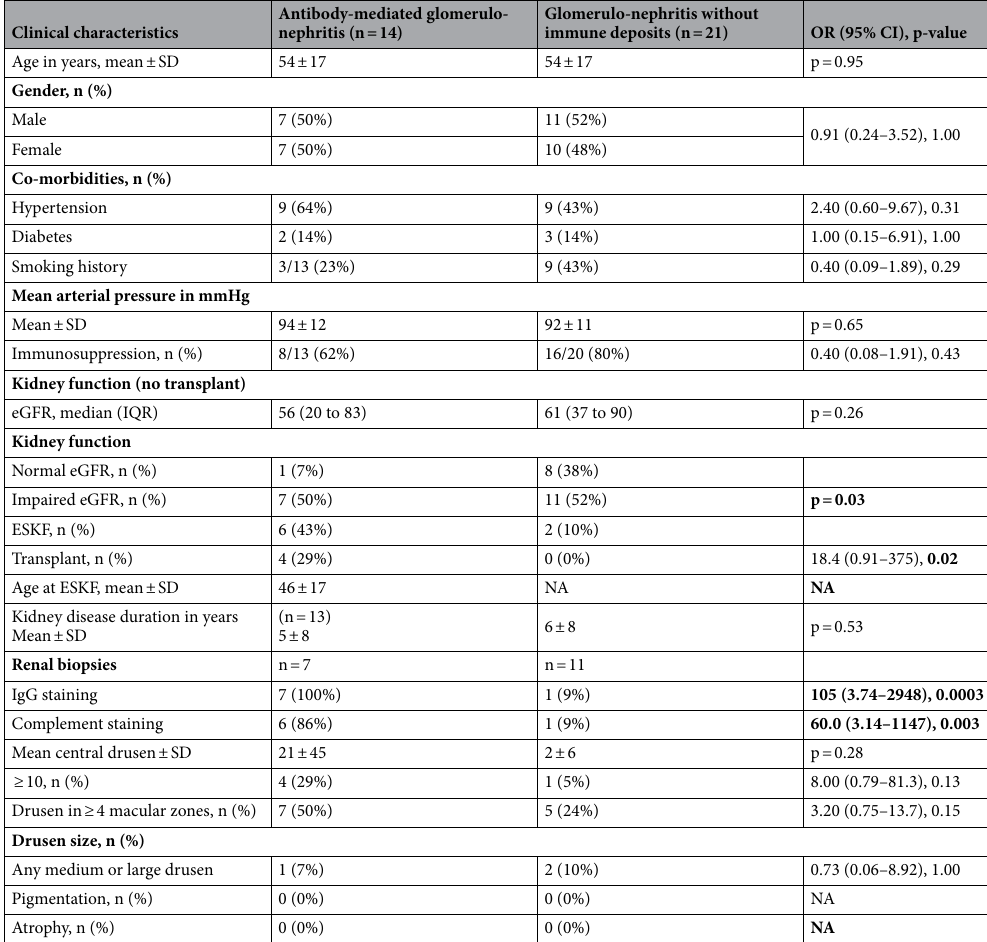
Table 5. Clinical features and drusen in antibody-mediated glomerulonephritis and glomerulonephritis without immune deposits. Significant values are in bold. Antibody-mediated glomerulonephritis included membranous nephropathy and anti-GBM disease. Glomerulonephritis without immune deposits included ANCA-associated vasculitis and minimal change disease. eGFR estimated glomerular filtration rate mL/ min/1.73 m 2 , CI confidence interval, IQR interquartile range, OR odds ratio, SD standard deviation, NA not